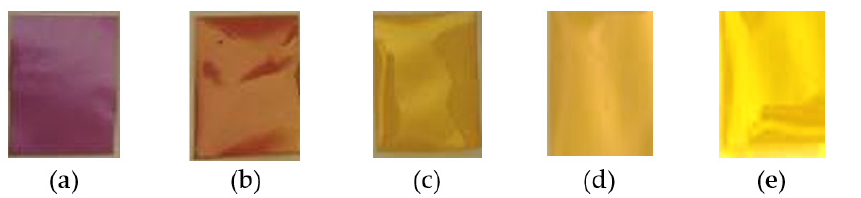
Figure 1. Appearance of the polymer film sample with 20% TCE after radiation with doses of ( a ) 0 kGy; ( b ) 2 kGy; ( c ) 4 kGy; ( d ) 6 kGy; and ( e ) 12 kGy.